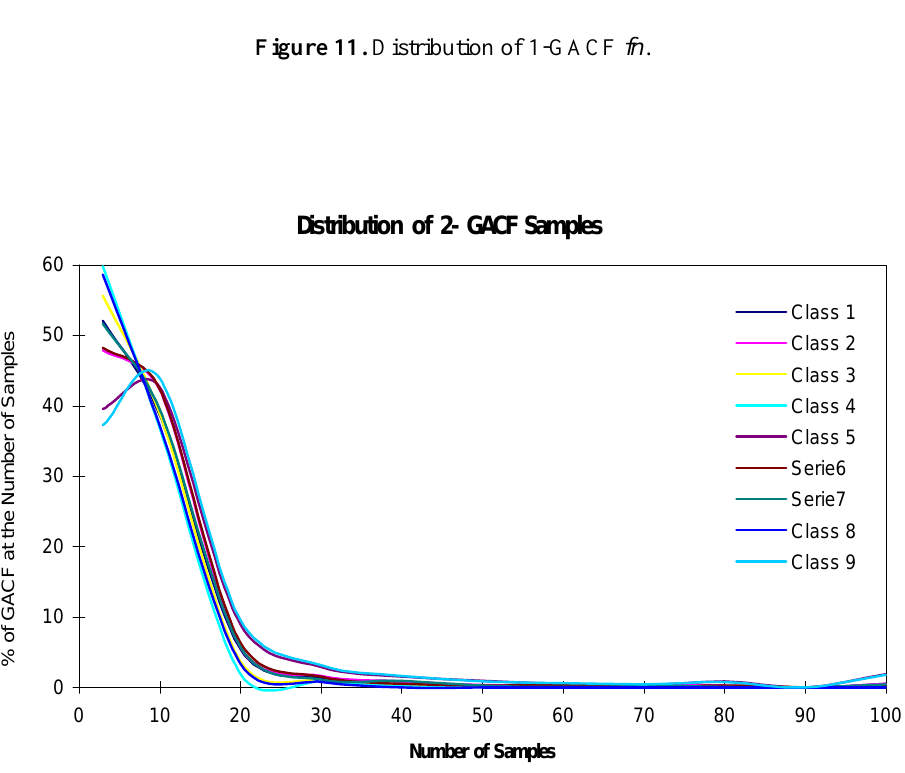
Figure 11. Distribution of 1-GACF fn .